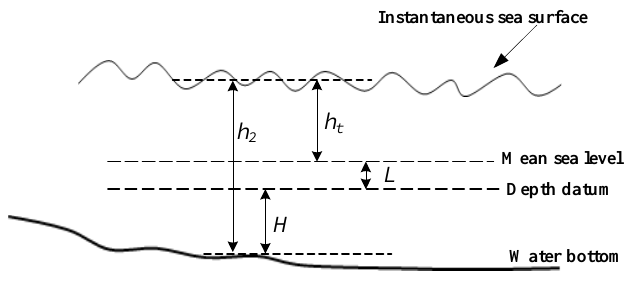
Figure 6. Diagram of datum conversion.